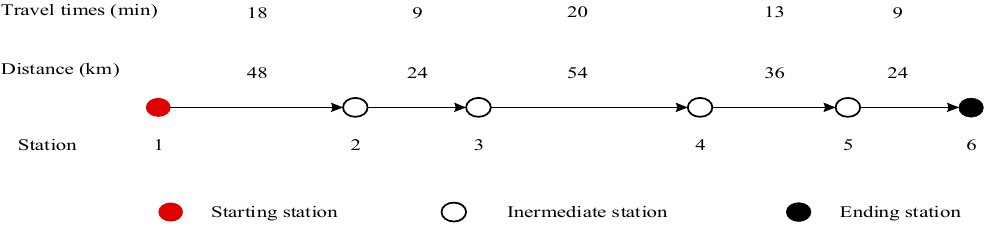
Figure 3. A small-scale outbound railway corridor. Table 6. Passenger demand for each OD in peak